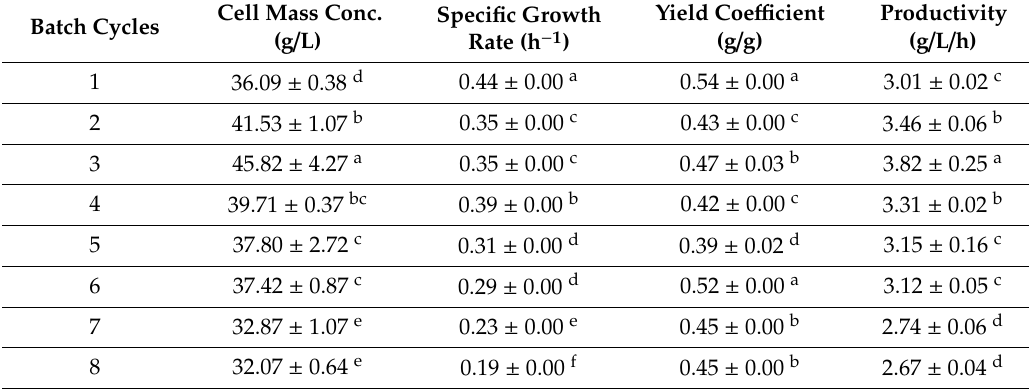
Table 3. Kinetic parameters of K. marxianus SS106 cell biomass production undergoing intensive multiple sequential batch simultaneous saccharification and cultivation in an aerobic bioreactor. Batch